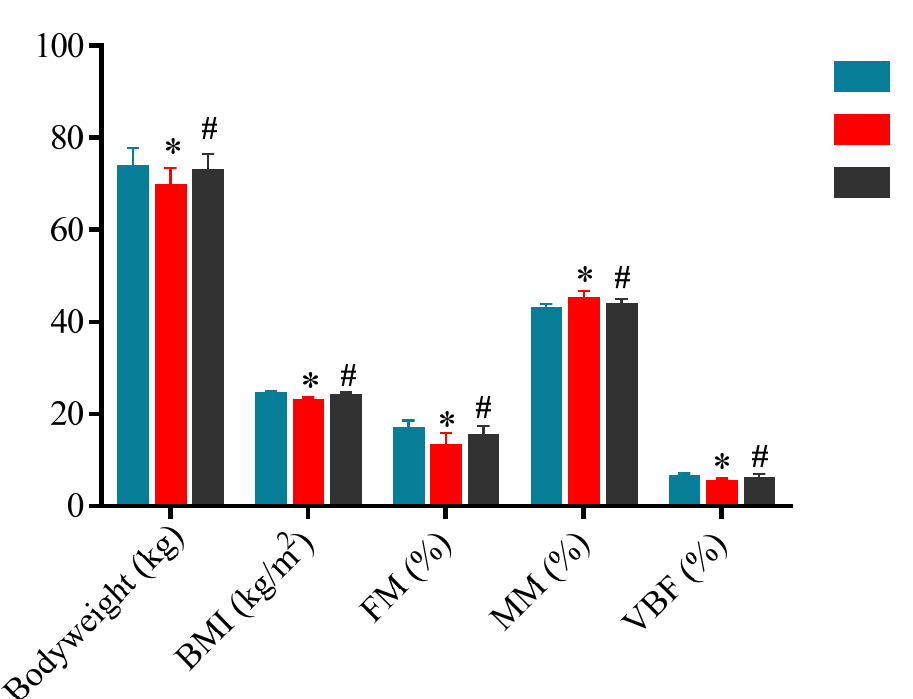
Figure 2. Descriptive characteristics of wrestlers’ body composition. Legend: BL—baseline values; P1—phase one: HISST combined with RWL; P2—phase two: HISST with no RWL procedures in- cluded; BMI—body mass index (kg/m 2 ); FM—fat mass (%); MM—muscle mass (%); VBF—visceral body fat (%); * statistically significant difference in relation to the baseline values, p ≤ 0.001; # sta- tistically significant difference in relation to phase P1, p < 0.01.